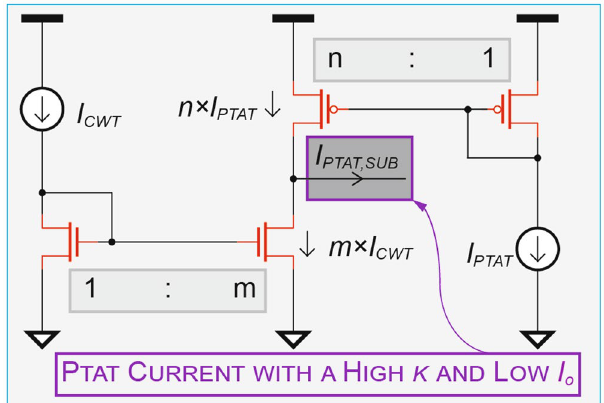
Figure 3. Implementation of the current subtractor employed to increase temperature conversion resolution by increasing the effective temperature coefficient k , where m = 1 and n = 3.